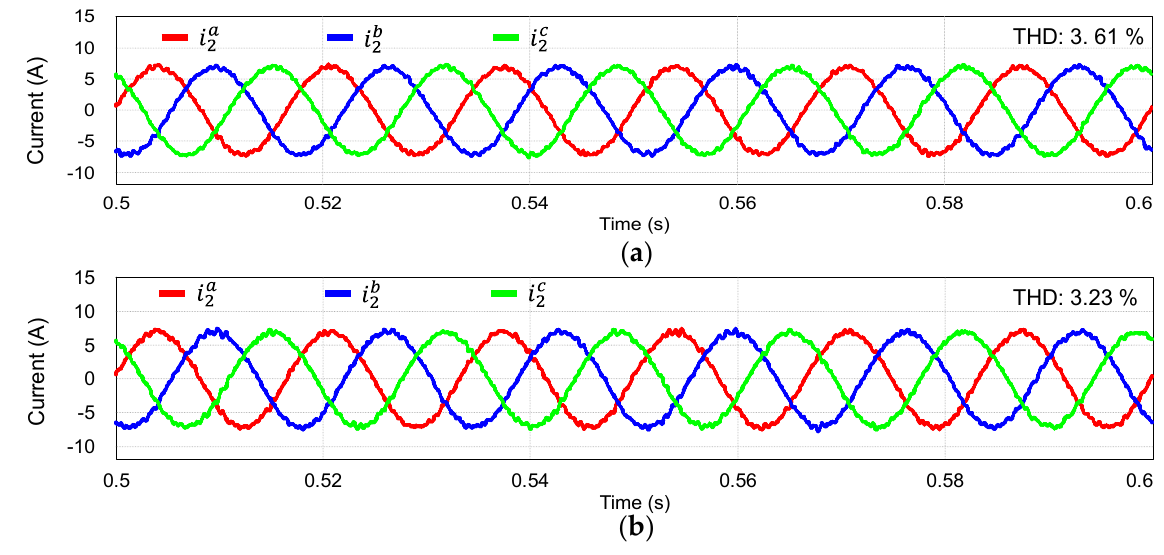
Figure 11. Simulation results of the proposed controller with L g = 1 mH. ( a ) Three-phase grid currents under distorted grid voltages in Figure 5a; ( b ) three-phase grid currents under distorted and imbalanced grid voltages with e a drop to 83.33% of the nominal value in Figure 7a.